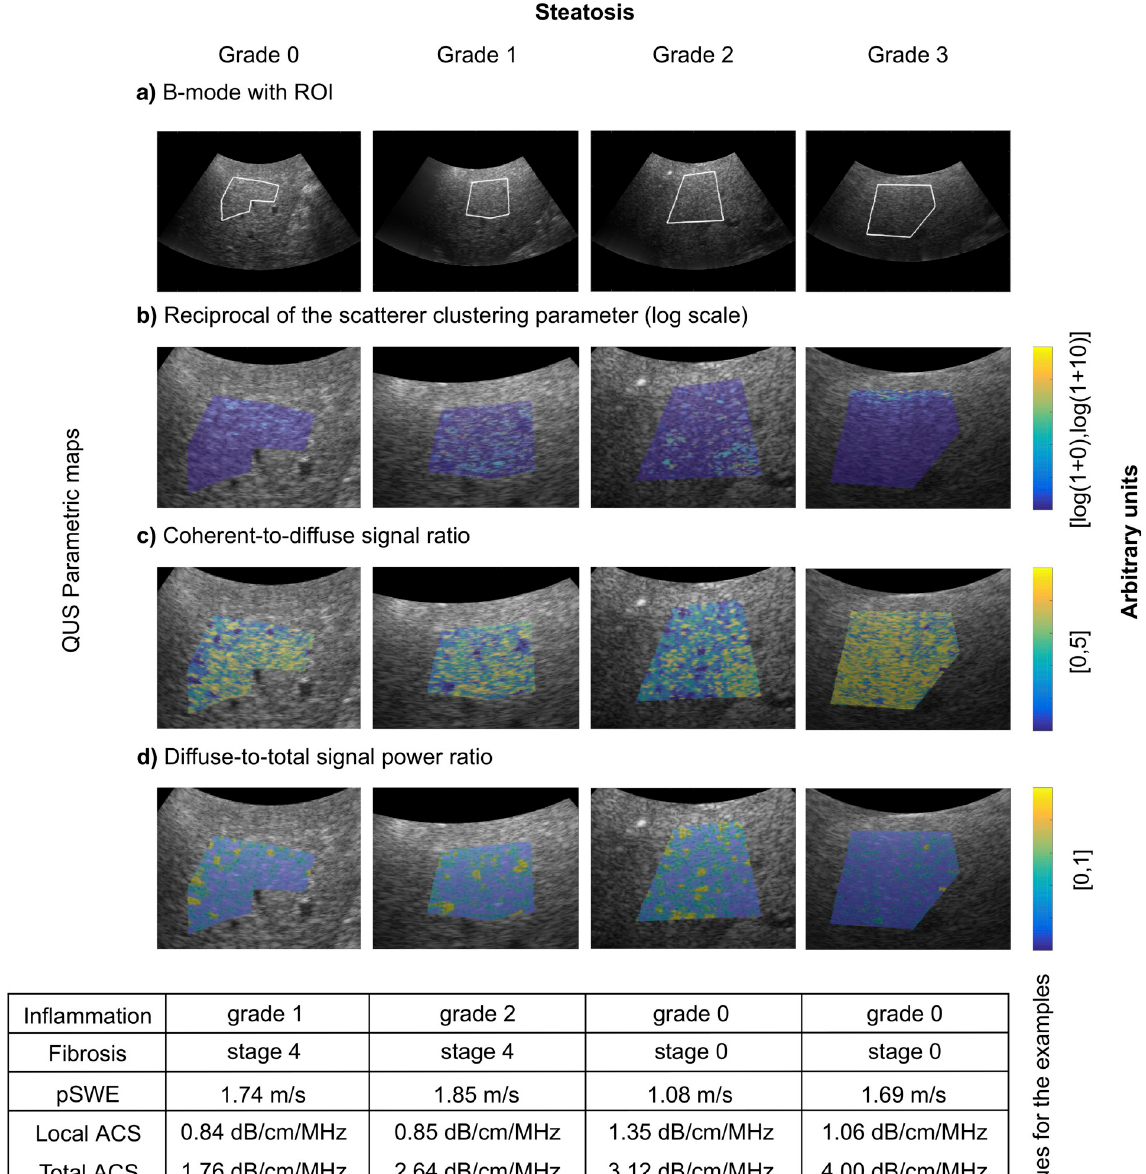
Fig 1. Examples of histopathology-proven steatosis grades. From left to right with histopathology-proven steatosis grades: 1) 62-year-old man with hepatitis B virus with steatosis grade 0; 2) 62-year-old man with NASH and hepatitis B virus with steatosis grade S1; 3) 38-year-old man with NASH with steatosis grade S2; and 4) 69-year-old woman with NASH with steatosis grade S3. Displayed images: (A) Representative B-mode acquired in the right liver lobe and corresponding QUS parametric maps (zoomed in on ROIs) illustrating (B) reciprocal of scatterer clustering parameter (log scale), (C) coherent-to-diffuse signal ratio, and (D) diffuse-to-total signal power ratio. Yellow indicates higher values, whilst dark blue values indicate lower values. In the table are reported the inflammation grade and the fibrosis stage, as well as the corresponding point shear wave elasticity (pSWE), and local and total attenuation coefficient slopes (ACS). for each of the 11 features taken individually. For inflammation grade 0 vs. � 1, the AUC of total attenuation was within the AUC’s 95% CI corresponding to the best tested combina- tion of features. For inflammation grade A0-1 vs. A2- = 3, the AUC of parameter k was